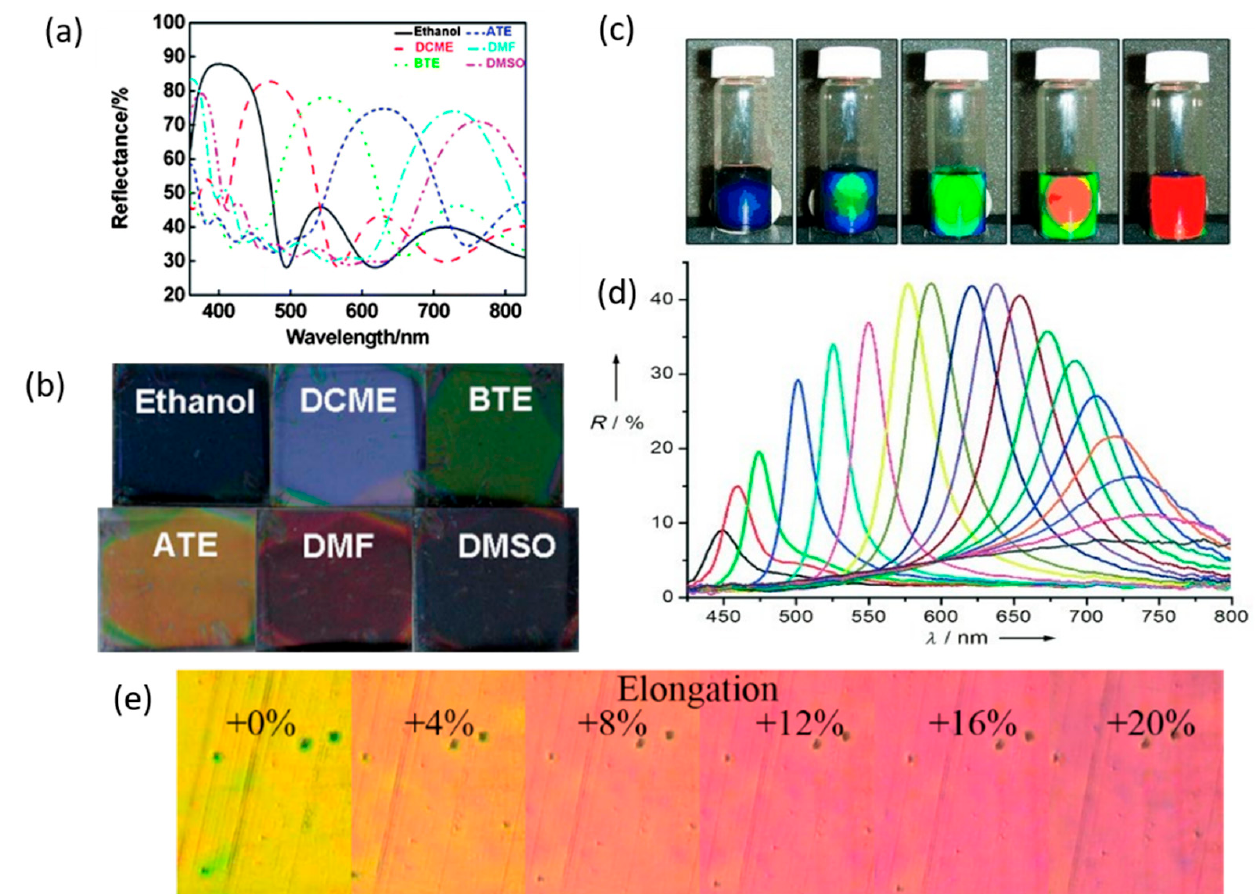
Figure 2. Different cases of tunable photonic crystals. ( a ) ( b ) Reflectance spectra and visual effect of PMMA- co -PHEMA- co -PEGDMA) and titania photonic crystals (PhCs) in different solvents. Adapted from reference [32] by permission of The Royal Society of Chemistry. ( c ) ( d ) Effect of the magnet–sample distance on polyacrylate-capped superparamagnetic magnetite (Fe 3 O 4 ) colloidal nanocrystal clusters (CNCs). Adapted from reference [110] by permission of John Wiley & Sons. ( e ) Changing of structural color of grating nanostructured polydimethylsiloxane membrane/TiO 2 as the elongation increases. Adapted from reference [31].